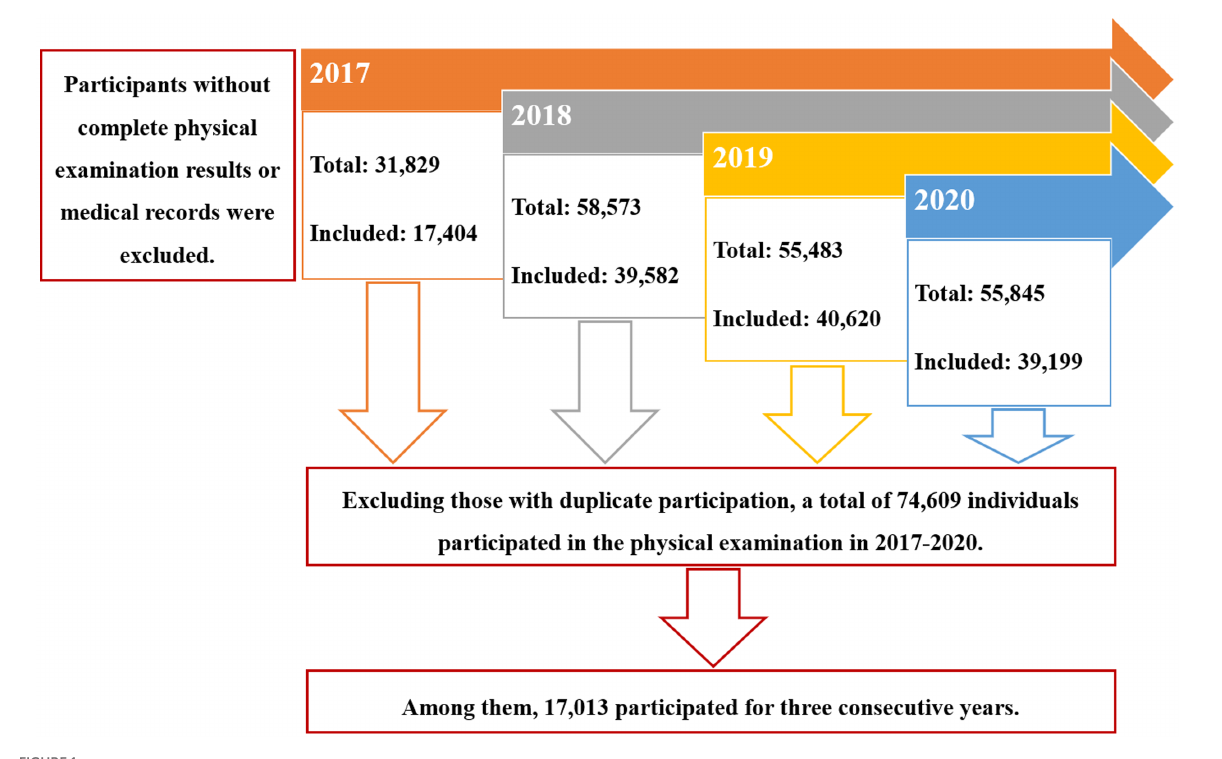
FIGURE 1 Flow diagram of